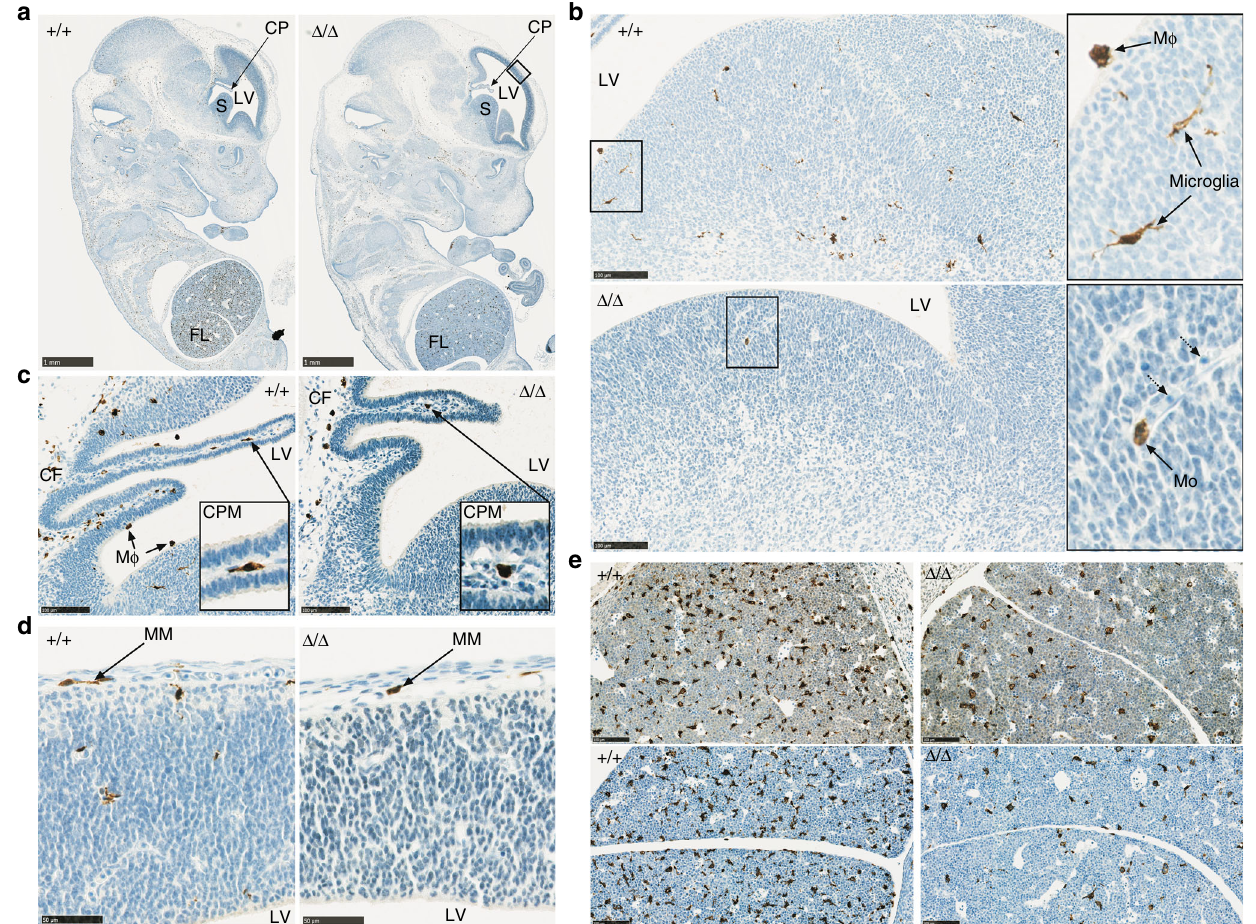
Fig. 8 FIRE deletion results in a reduction of embryonic macrophages. a Formalin- fi xed paraf fi n-embedded embryos (E13) were stained with antibodies against IBA1. Images are representative of seven embryos per genotype at E12, E12.5, and E13 and four repeat experiments. CP choroid plexus, LV lateral ventricle, S striatum, FL fetal liver. Black rectangle indicates the area magni fi ed for panel d . Scale bar = 1 mm. b View of the striatum from E12.5 embryos highlighting IBA1 + microglia and ventricular macrophages (M Φ ) in the control embryo and a monocyte (Mo) in the FIRE de fi cient embryo. Dotted arrows point to immature red blood cells in a blood vessel. Scale bar = 100 µ m. c Images of the choroid plexus in the lateral ventricle (LV) of E12.5 embryos. CPM choroid plexus macrophage, M Φ ventricular macrophages, CF choroidal fi ssure. Scale bar = 100 µ m. d IBA1 + meningeal macrophages (MM) in the forebrain (boxed area in panel a ) of control and Csf1r Δ FIRE/ Δ FIRE embryos at E12.5. Scale bar = 50 µ m. e IBA1 + fetal liver monocytes at E12 and E13 in upper and lower panels, respectively. Scale bar = 100 µ